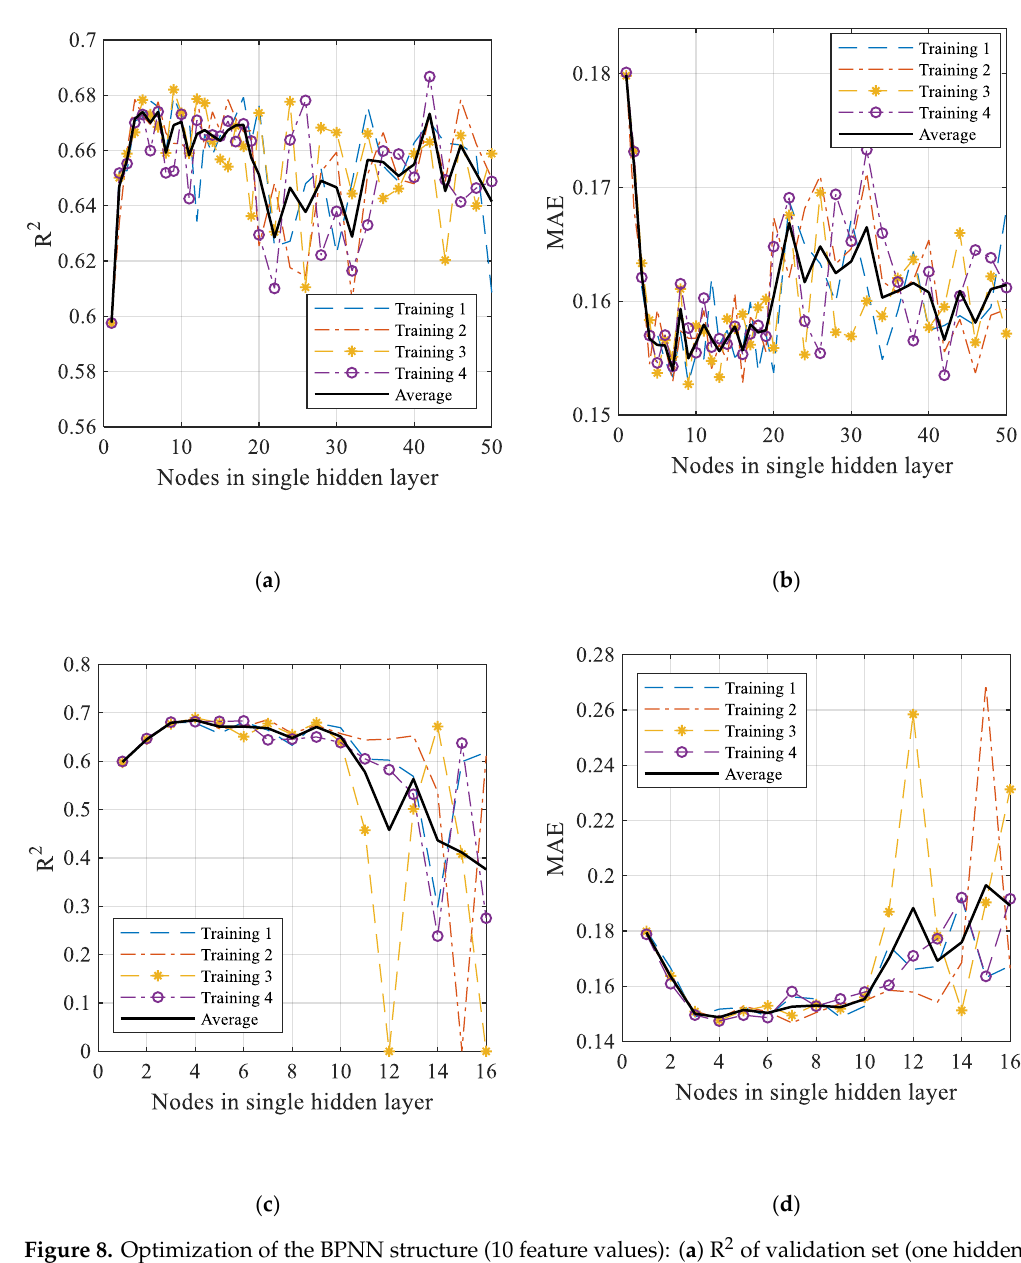
Figure 8. Optimization of the BPNN structure (10 feature values): ( a ) R 2 of validation set (one hidden layer); ( b ) MAE of validation set (one hidden layer); ( c ) R 2 of validation set (two hidden layers); ( d ) MAE of validation set (two hidden layers).